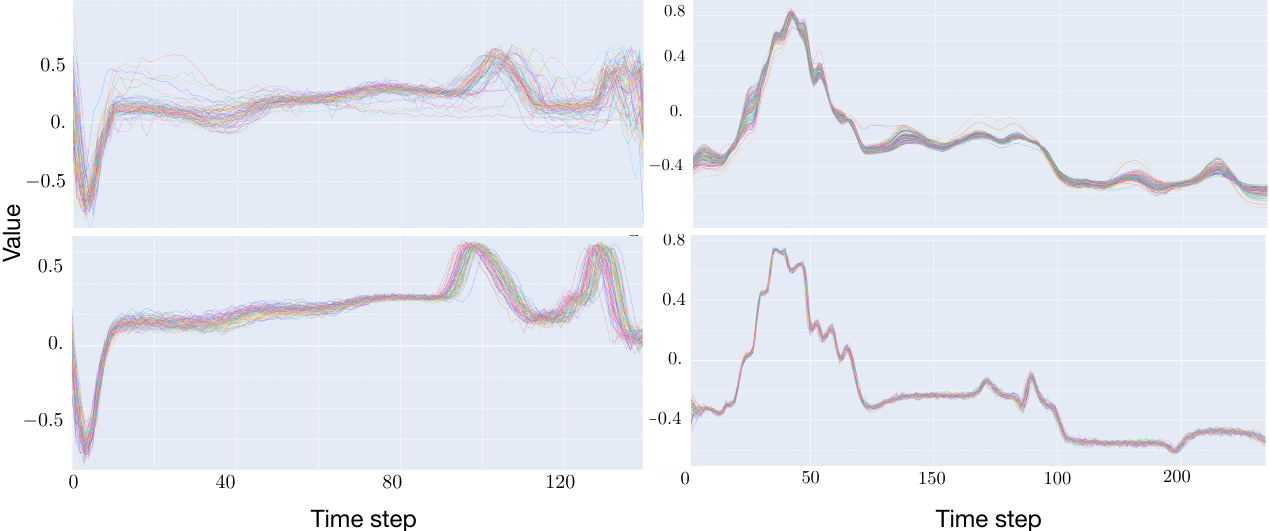
Figure 1. Batch of time series from dataset D2 ( left ) and dataset D3 ( right ) using the GAN-based data augmentation method. ( Top ) Real data. ( Bottom ) Synthetic